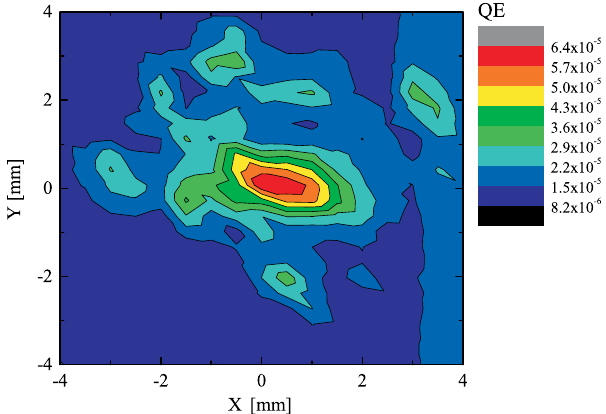
FIG. 8. QE after the cavity was vented with nitrogen.